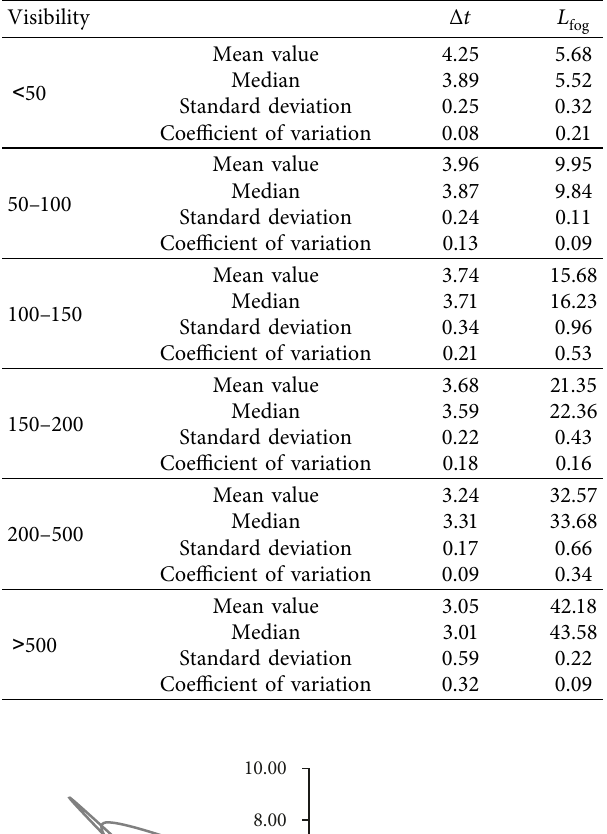
Table 3: Statistical results of parameters. Visibility